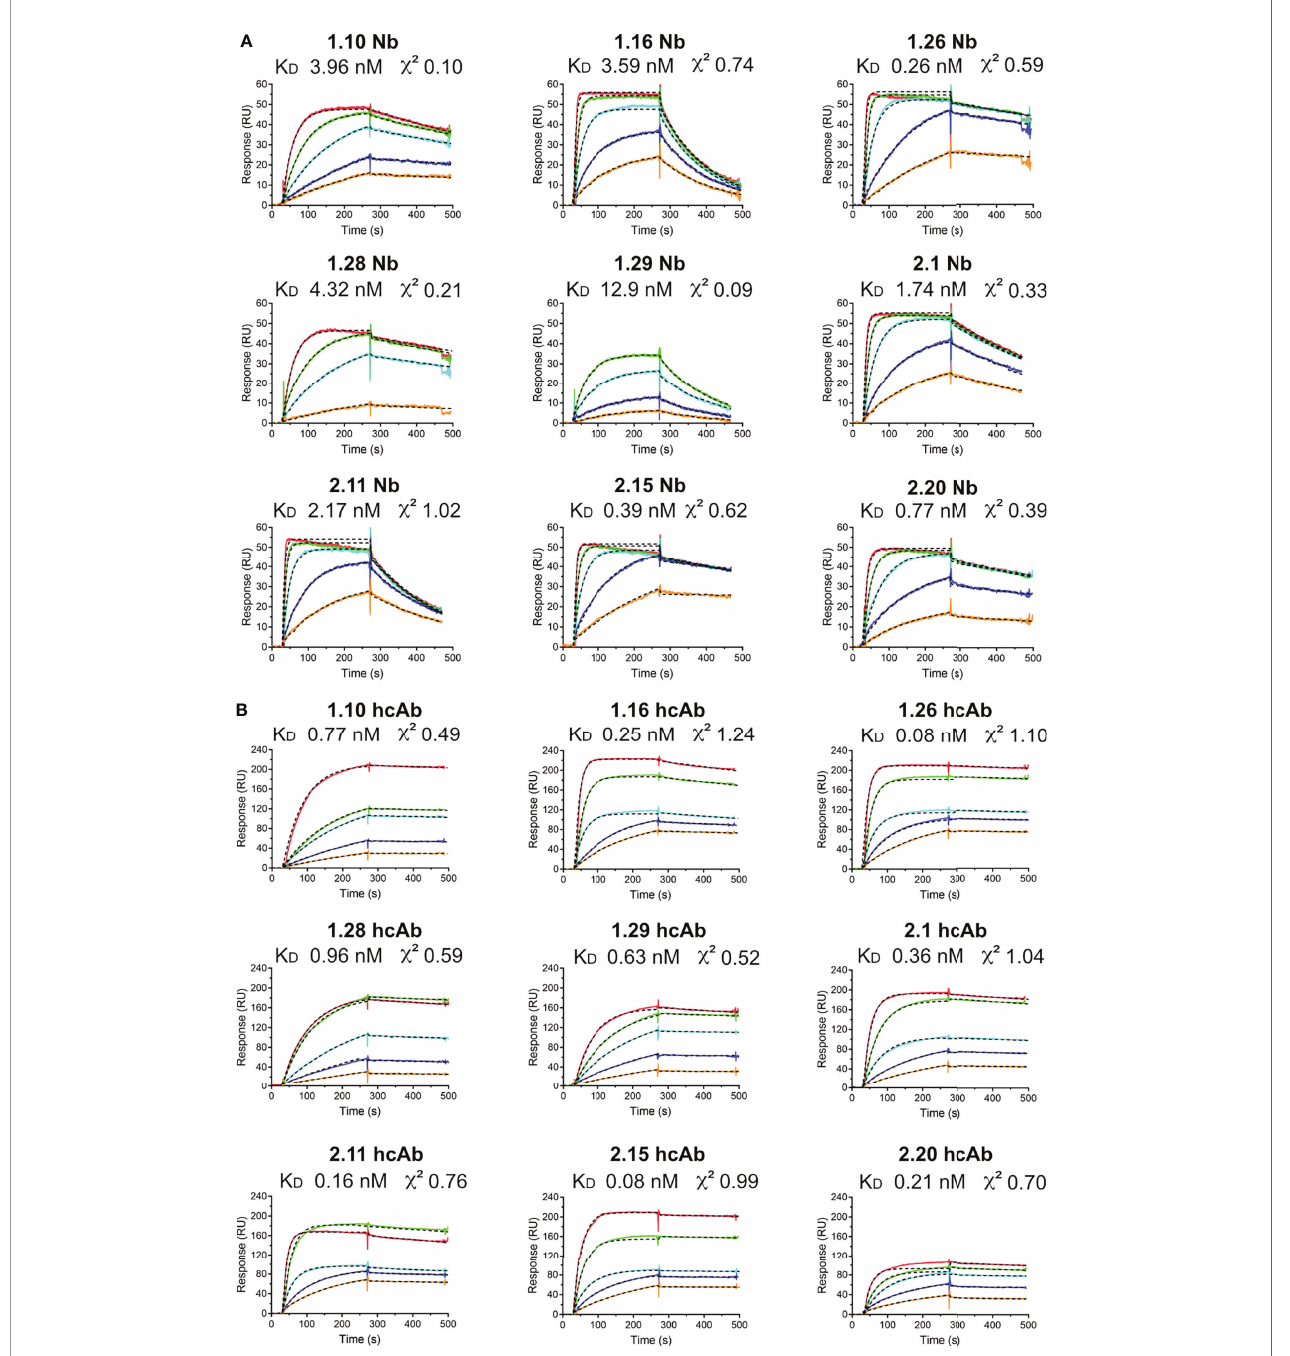
FIGURE 2 | Nb and hcAb binding to the SARS-CoV-2 RBD ligand in real time. Overlayed sensorgrams recorded during the association and dissociation of the indicated Nbs (A) or hcAbs (B) through BIAcore sensor chip surfaces with captured RBD. Nb or hcAb concentrations of 5 (orange), 10 (blue), 25 (cyan), 50 (green) or 100 nM (red) were injected through the RBD and a control surface. The plots show the speci fi c response (RU) after double referencing (see Materials and methods ). The discontinuous dark lines represent the curve fi tting to a 1:1 Langmuir model for determination of the kinetic constants, shown in Table S1 . The equilibrium dissociation contents (K D ) and the fi tting c 2 are indicated